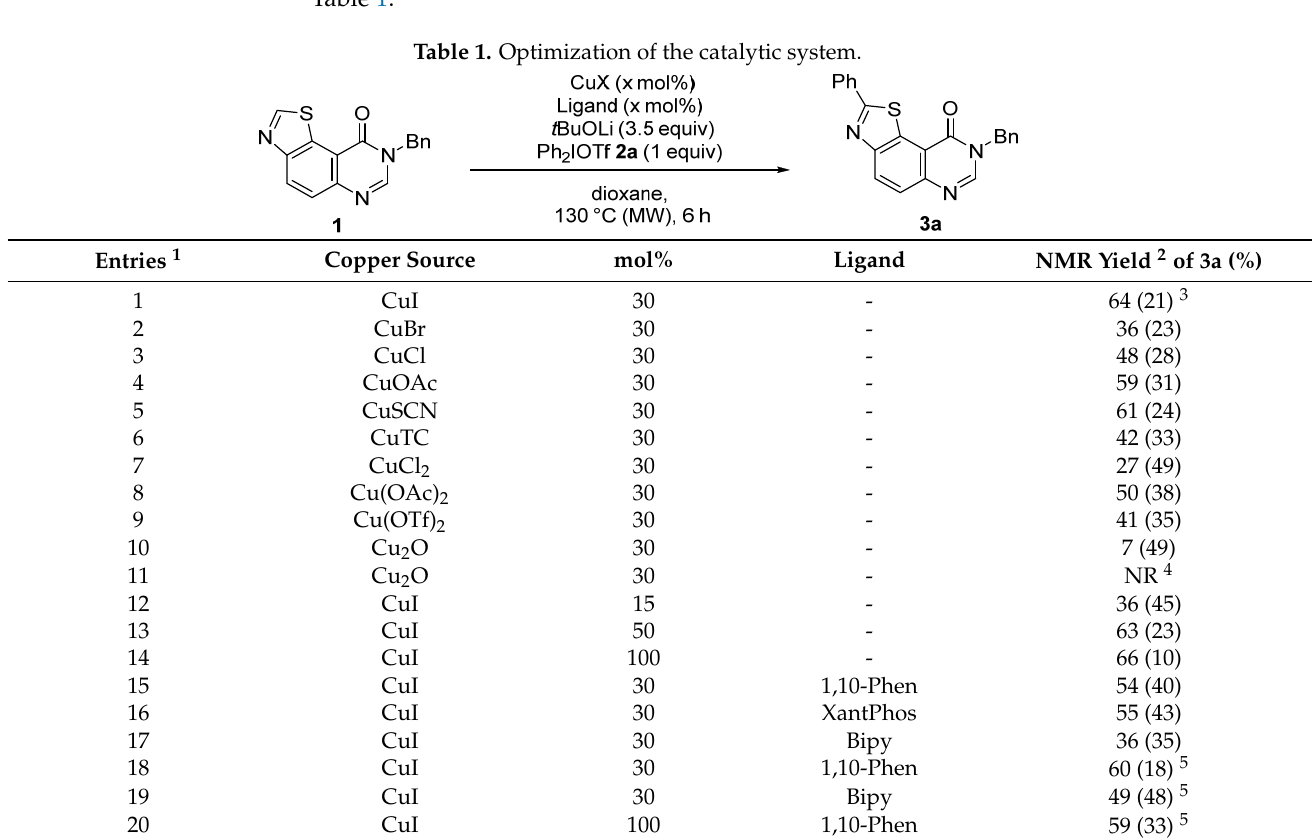
Table 1. Optimization of the catalytic system.